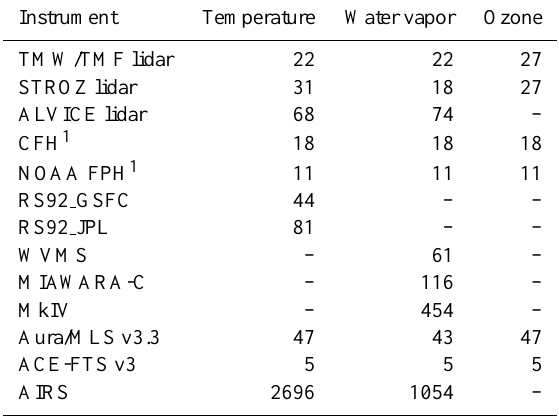
Table 3. Number of observations coincident with MIPAS for temperature, water vapor, and